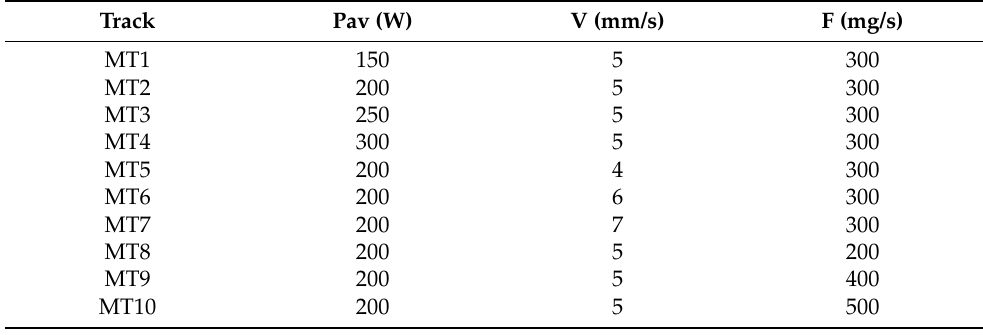
Table 1. Laser cladding parameters [19].